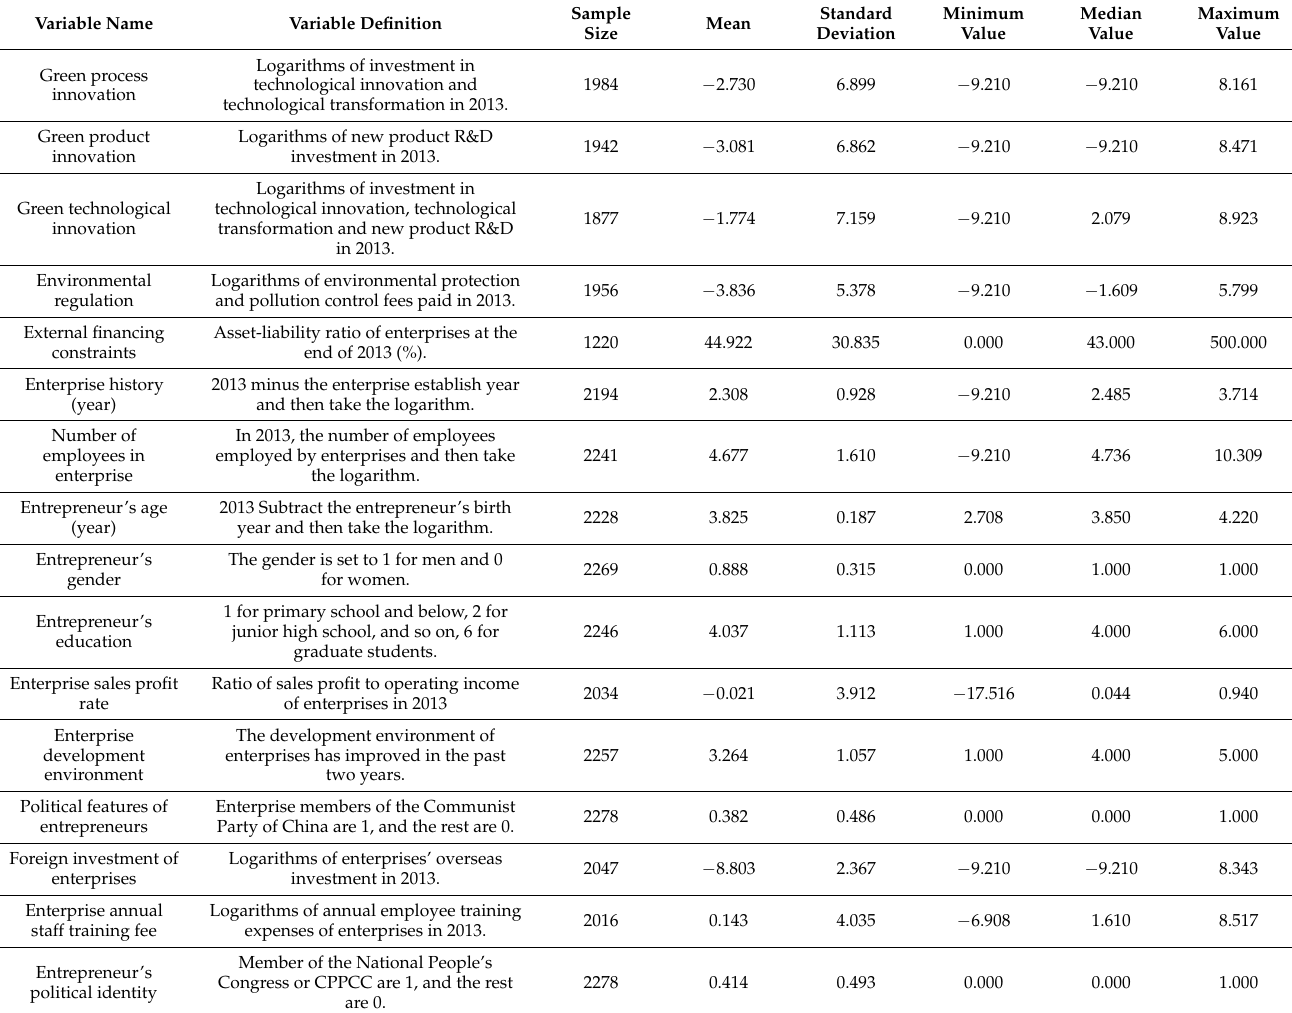
Table 1. Definition and statistical characteristics of